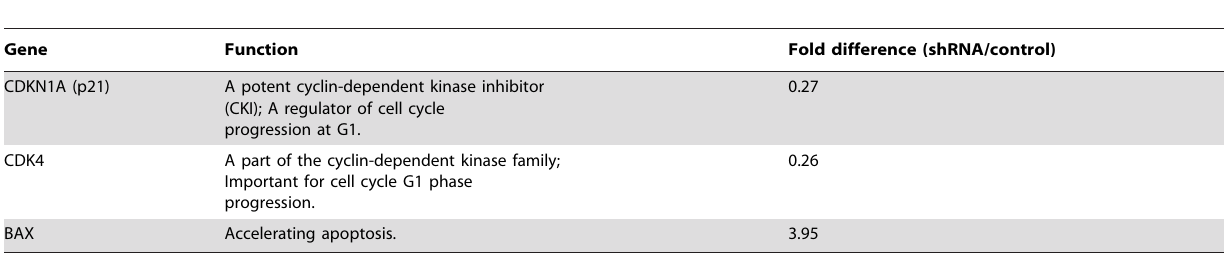
Table 1. The human Cancer Drug Resistance & Cell Cycle RT 2 Profiler PCR Array results were compared between ALDH1A1 knockdown and